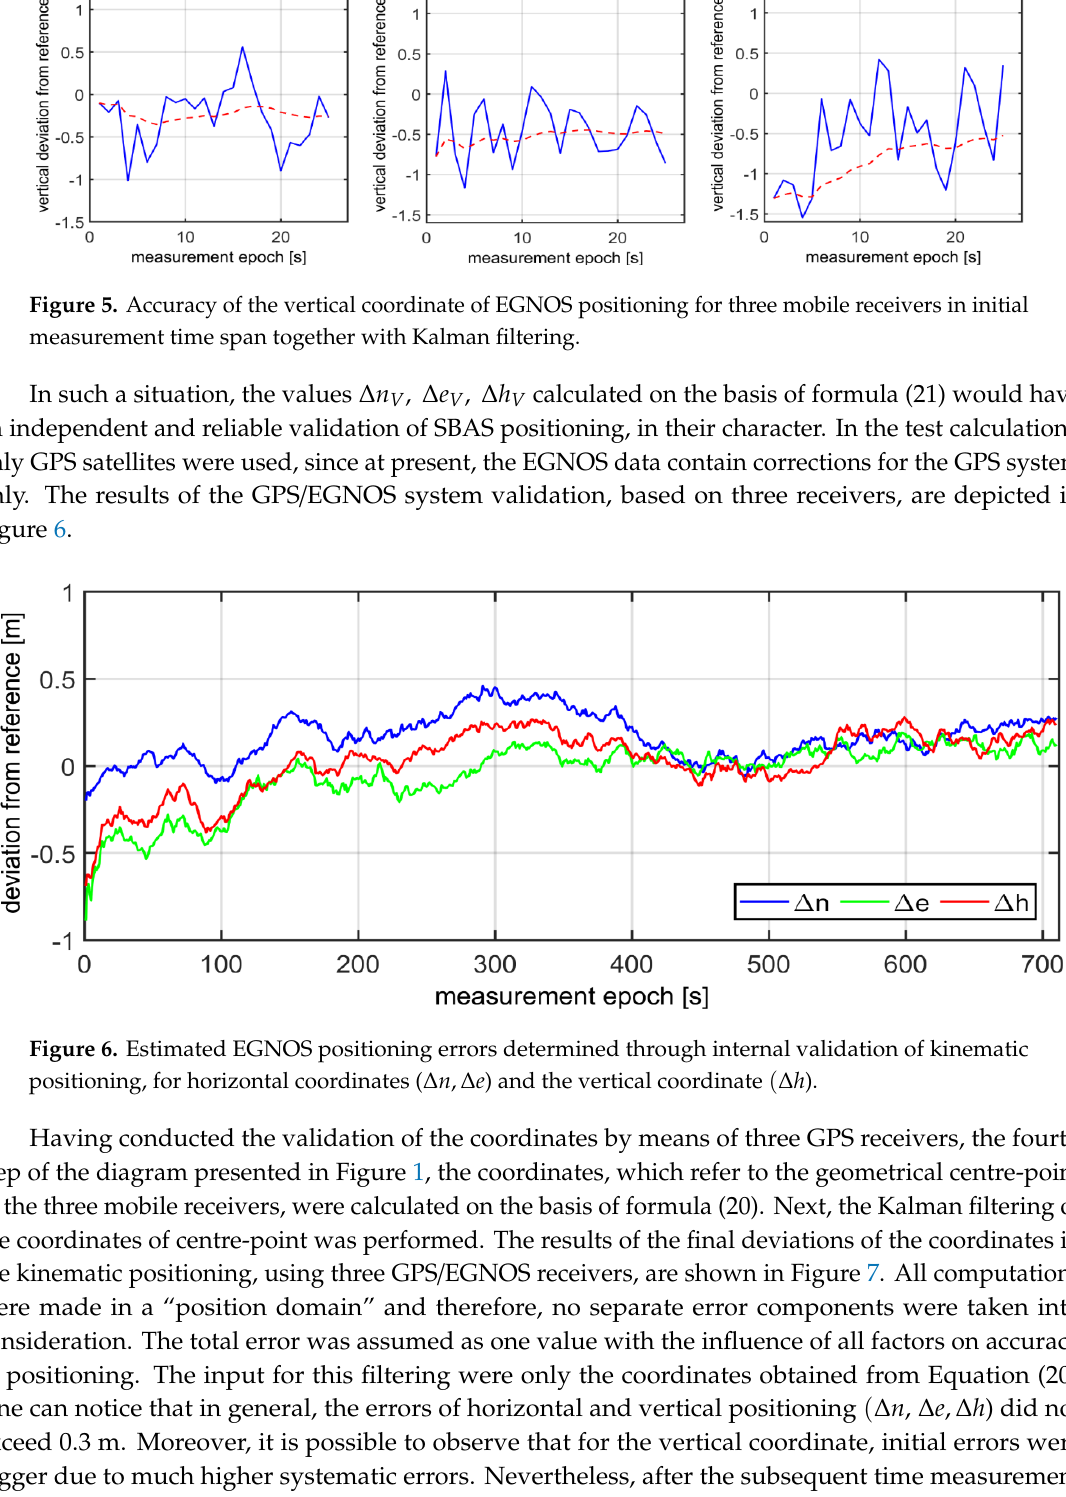
Figure 7. True errors of final GPS-EGNOS positioning by means of three GPS receivers and Kalman filter. The vertical coordinate in GNSS positioning techniques is usually burdened with the biggest errors, which adversely affect air navigation. Although the final solution is affected with all GNSS positioning errors, it should be stressed that the impact of errors through the applied algorithm has been greatly reduced. The presented approach depicts that there are various possibilities of enhancing the accuracy of positioning, which exploit independent measurement methods.